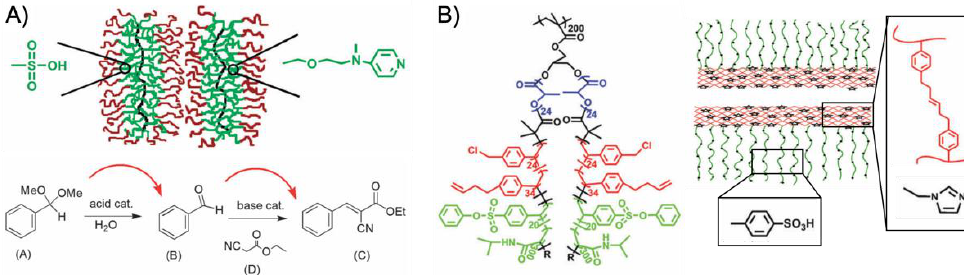
Figure 6. Cascade catalysis with bottlebrushes. ( A ) Acid and base catalysts site-isolated in two bottlebrushes. ( B ) Hollow brushes with base catalyst in the cross-linked shell and acid catalyst on the stabilizing corona. Adapted with permission of [83] and [84]. Copyright 2014 and 2018 Royal Society of Chemistry.